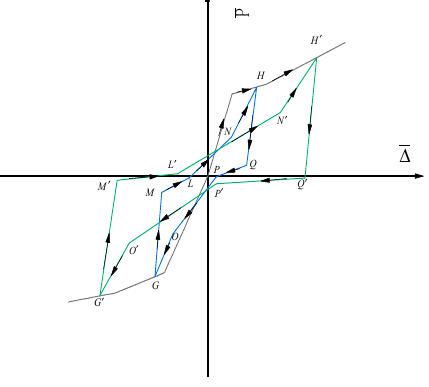
Figure 19. Hysteretic model. Figure 19. Piecewise hysteresis curves.